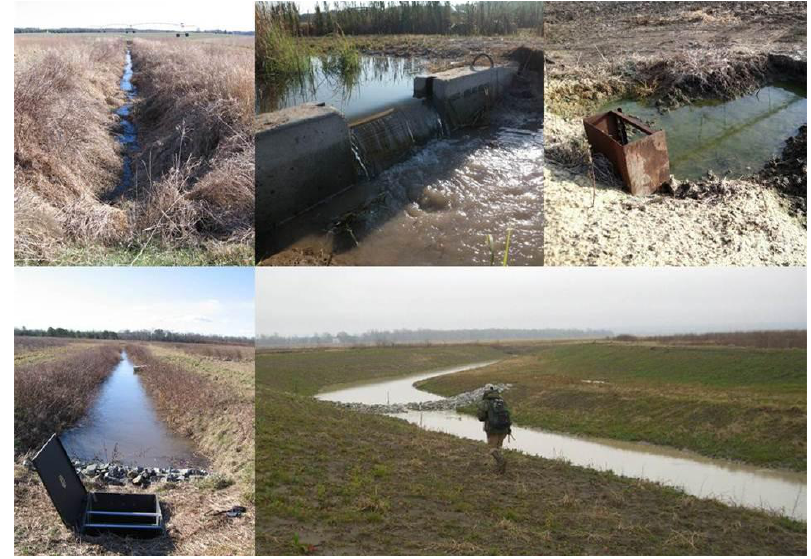
Figure 5. Various water control structures. Far left , downstream (top) and upstream (bottom) of a weir integrated into a ditch crossing on a farm on the Delmarva Peninsula, Maryland, USA (photos courtesy Dr. Tom Fisher). Top center , prefabricated slotted concrete weir in an experimental ditch system located on the campus of Arkansas State University. Top right , Flashboard riser with pipe draining into intermittent stream. Like the slotted concrete weir, boards can be added or removed to adjust the level of water retention. Although this structure is technically not located in a stream, it functions similarly in that it intercepts water in a channelized flow-path as opposed to sheetflow. Bottom right , demonstration ditch located near Yazoo City, Mississippi, USA. The terraces on the far bank are representative of a modified two-stage design, with the lower terrace being inundated during floods. This picture was taken during the rainy season. A smaller inset channel is not visible due to water depth. During the dry season the ditch is a series of shallow pools due to the presence of low-grade weir constructed of an earthen berms armored with